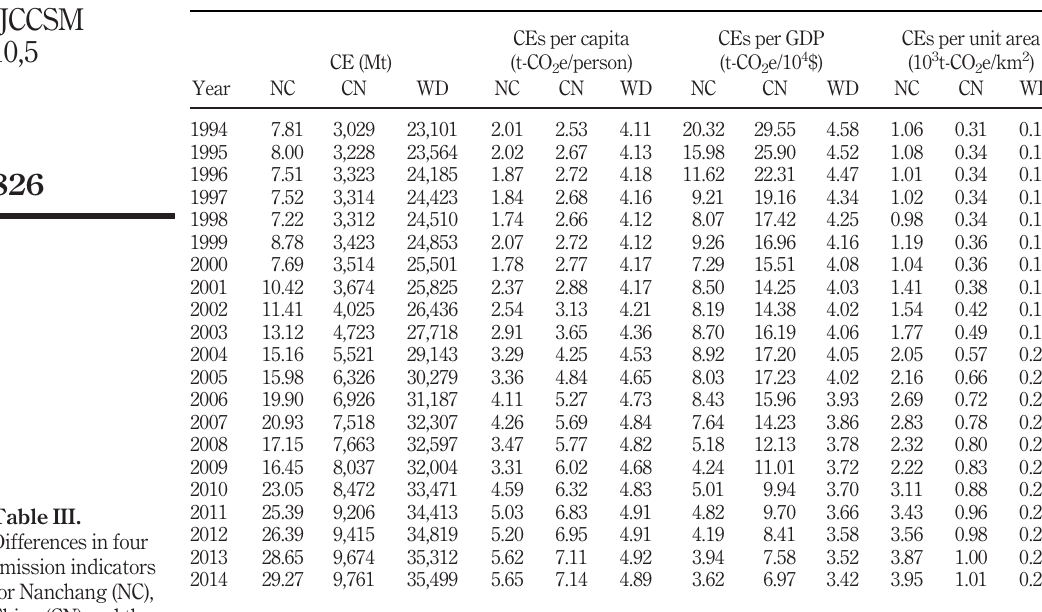
emission indicators